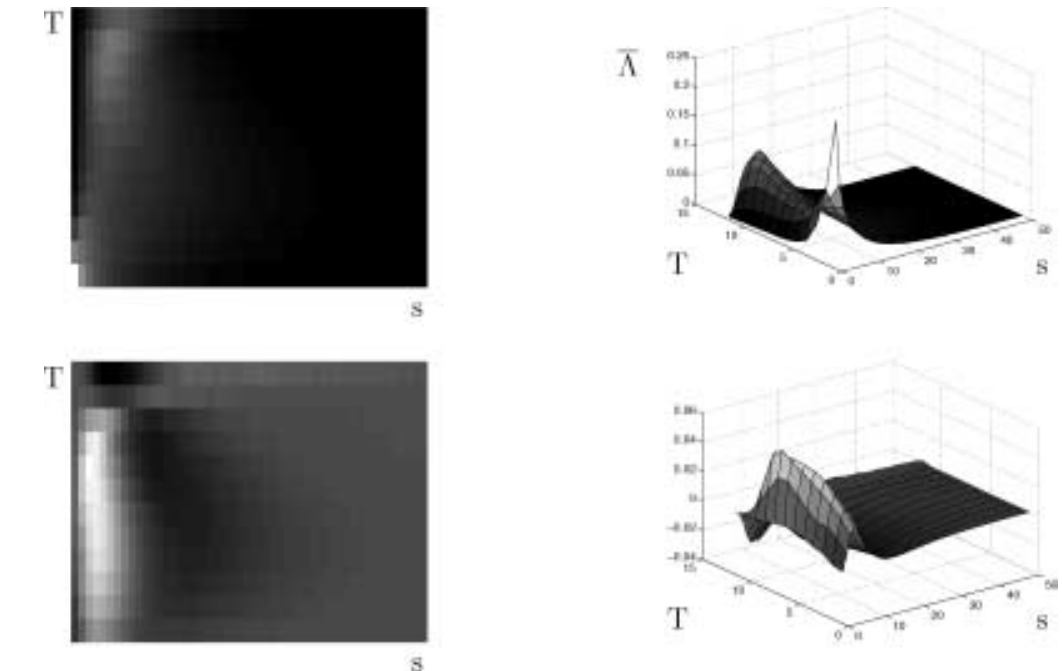
Fig. 6. Upper: The mean lacunarity matrix, Λ ( s , T | ω c ), computed from the central part of all the monolayer nuclei images in the good prognosis group. Lower: The difference between the Λ ( s , T | ω c ) computed from the peripheral and central parts of monolayer nuclei images in the good prognosis group. The matrices are visualized both as gray-scale and surface